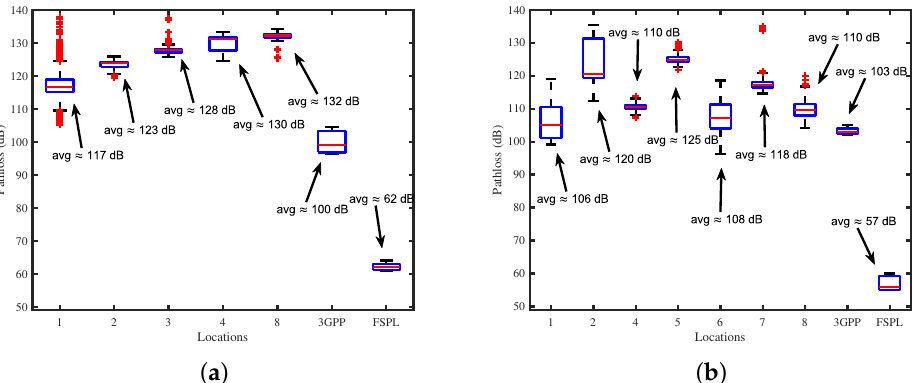
Figure 13. Box plot for path loss for Op1 and Op2 at all measurement locations, showing median value (red line), standard deviation (blue box), and outliers (red Plus signs). ( a ) Path loss for Op1. ( b ) Path loss for